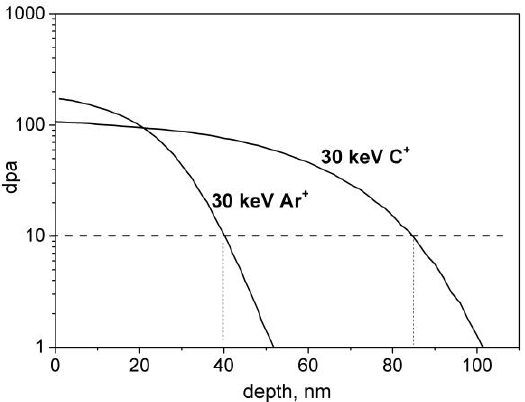
Figure 1. Stationary damage depth profiles under high-fluence ion irradiation.